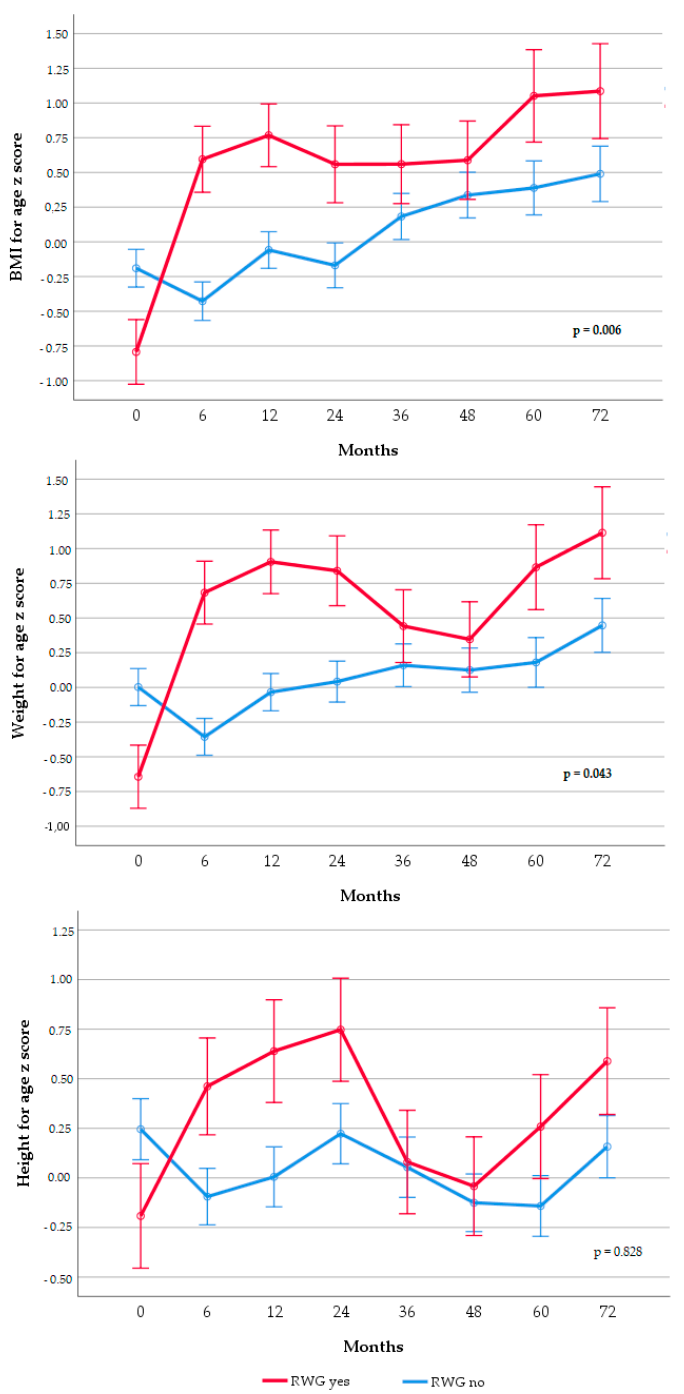
Figure 1. Trajectories of z-scores for infant BMI, weight, and height according to RWG from 0 to 6 months in infants. Results are displayed as estimated mean z-scores SEMs from repeated-measures ANOVA. BMI, body mass index; RWG, rapid weight gain. After adjusting by gestational age at birth, birth weight, maternal education, ethnicity, paternal and maternal BMI, and smoking during pregnancy, significant di ff erences remained in BAz ( p = 0.01), but not in WAz ( p = 0.16) or HAz ( p = 0.89). BMI: body mass index, RWG: rapid weight